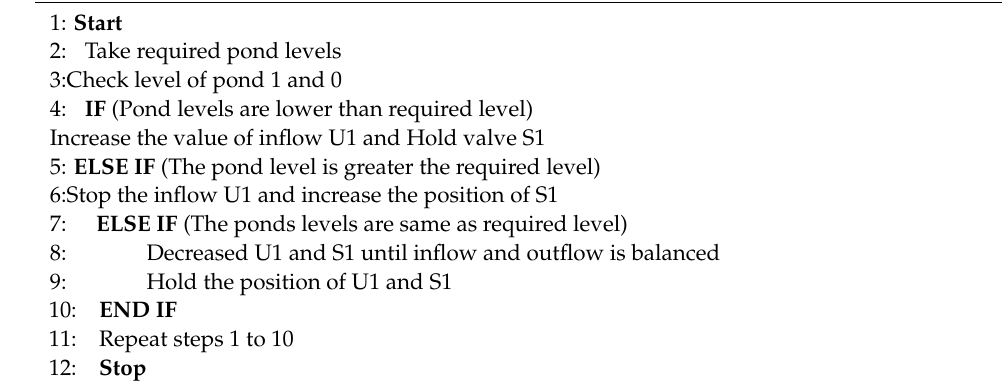
Algorithm 1. Simplified pseudo code for Fuzzy System 1 controlling levels of Pond 1 and